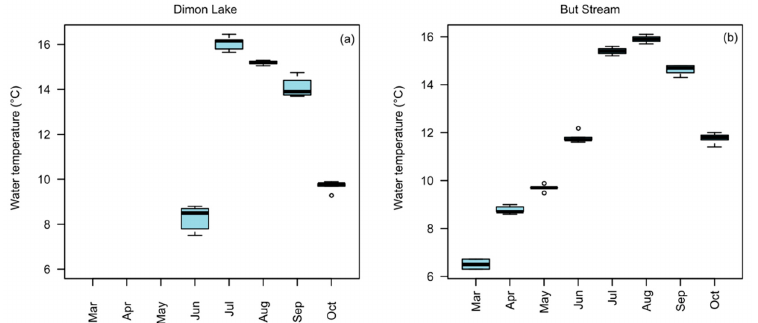
Figure 2. Boxplots of water temperature ( ◦ C) monitored at Dimon Lake ( a ) and But Stream ( b ) during the study period.